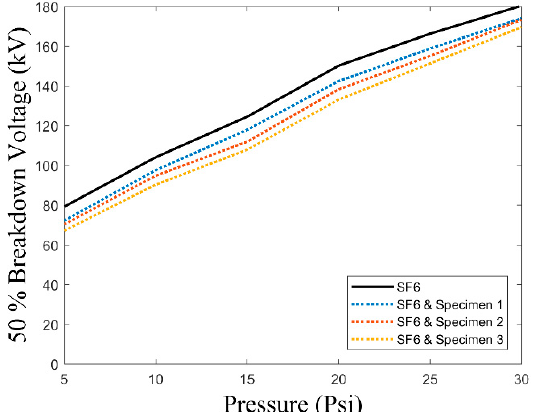
Figure 16. Comparison of disruptive discharge test results regarding SF 6 alone and in conjunction with open cell foam specimens of Table 4.